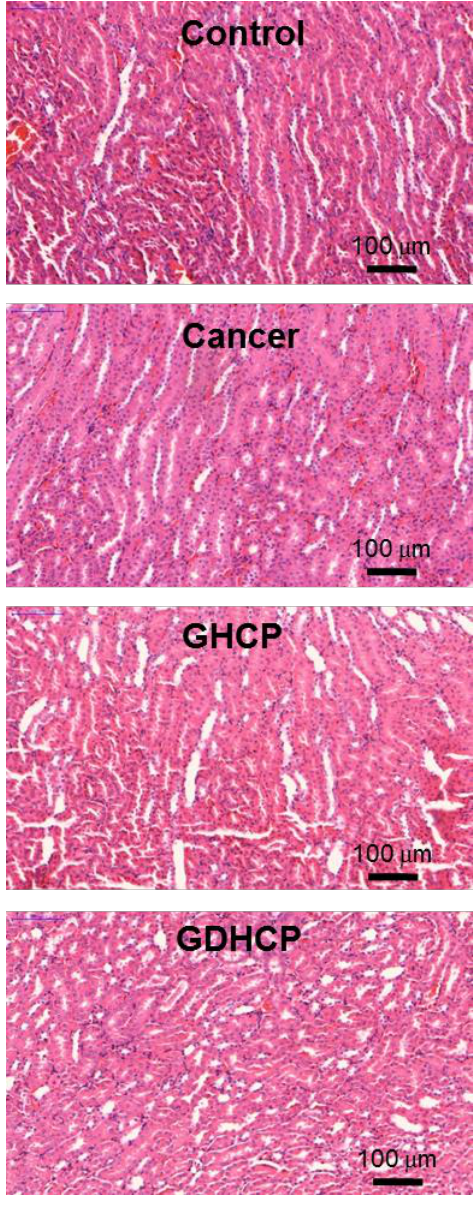
Figure 8. H&E stained slides of heart tissues extracted from control, cancer bearing, GHCP- and GDHCP-treated mice after 4 weeks. The slides were observed at 20×. The scale bars indicate 100 µm.